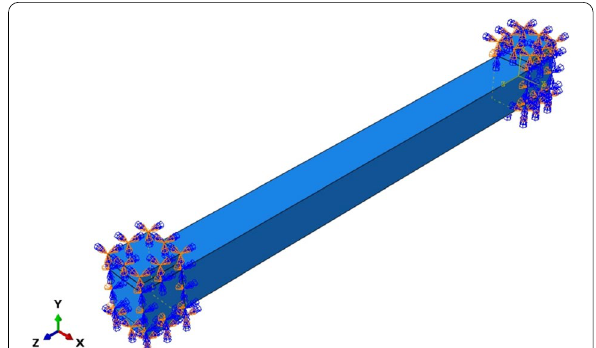
Fig. 26 Boundary condition of ABAQUS beam.